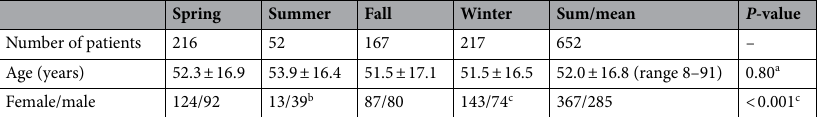
Table 1. Study demographics. Spring: March, April, and May; Summer: June, July, and August; Fall: September, October, and November; Winter: December, January, and February; a One-way analysis of variance; b a higher proportion of male patients than expected (P < 0.001; Chi-square test); c Chi-square test.